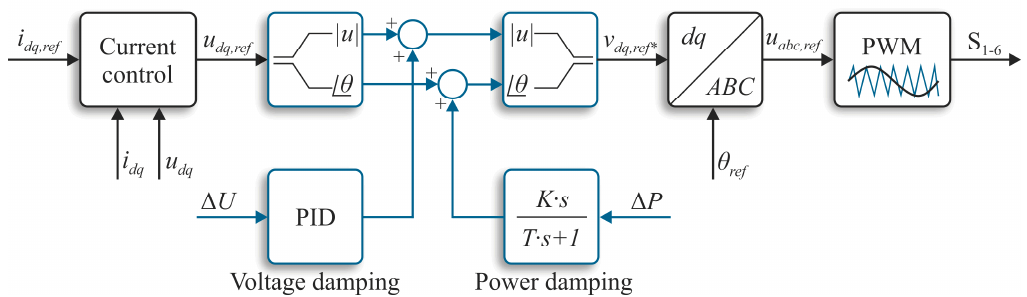
Figure 5. PID control modifying the inverter’s voltage magnitude and angle reference.